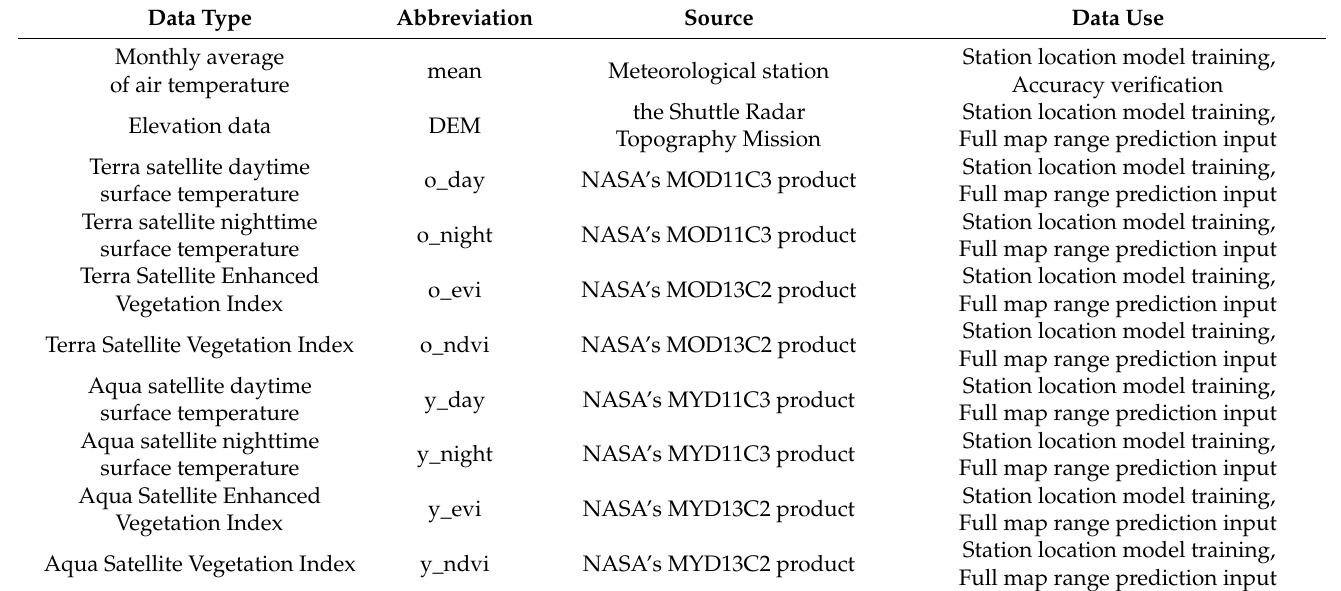
Table 2. Main data sources and their use in this